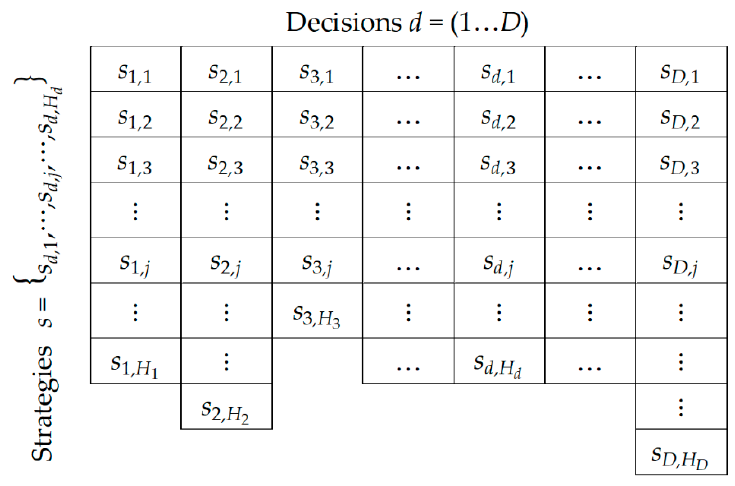
Figure 3. Strategies in each decision.